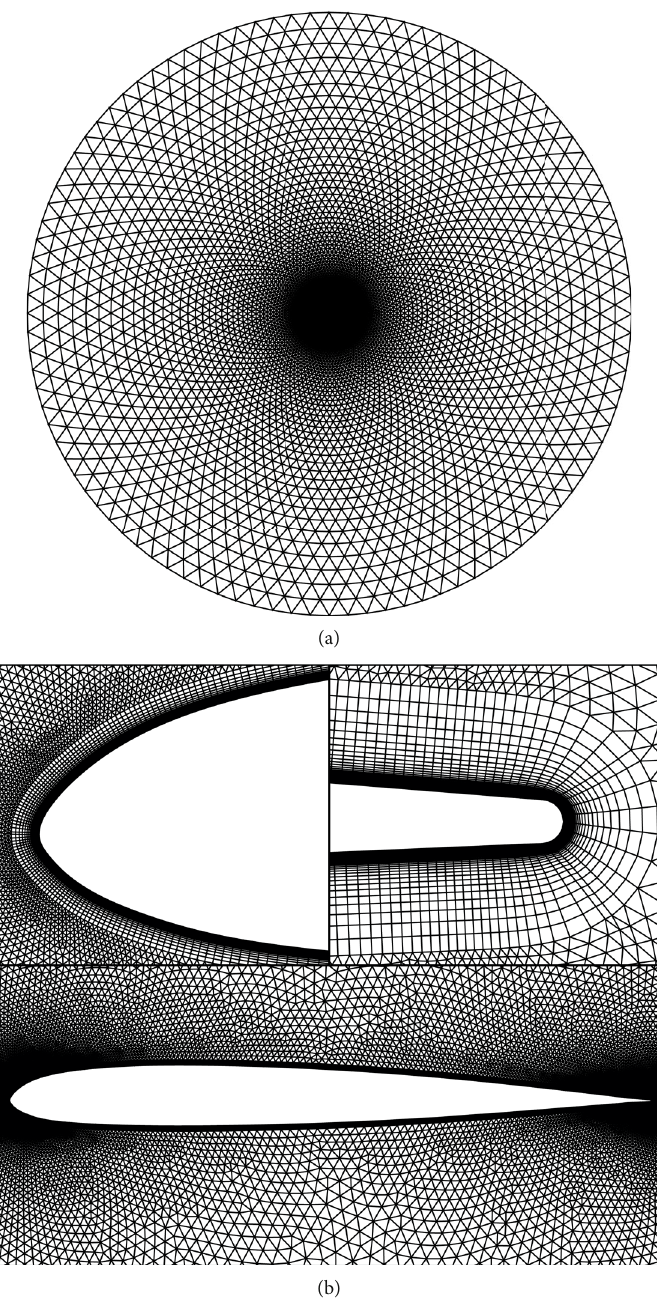
Figure 4: Medium mesh used in the present